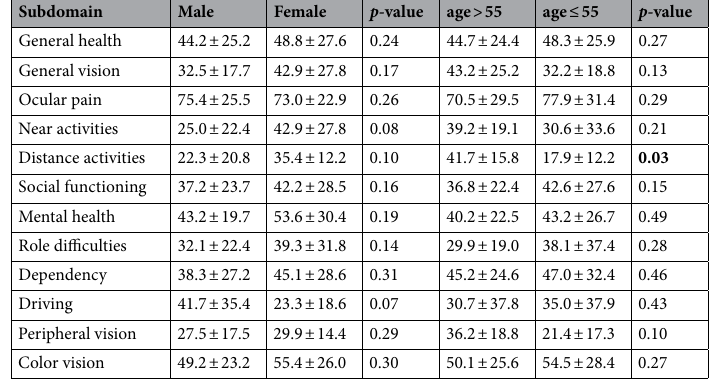
Table 4. Comparison of National Eye Institute-Visual Function Questionnaire (NEI-VFQ) according to the age and